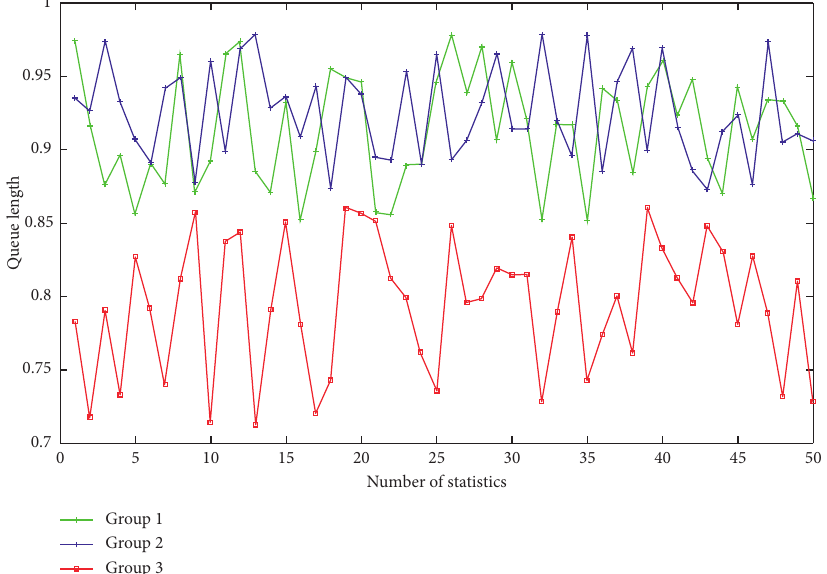
Figure 11: The maximum queue length of the system under a high congestion